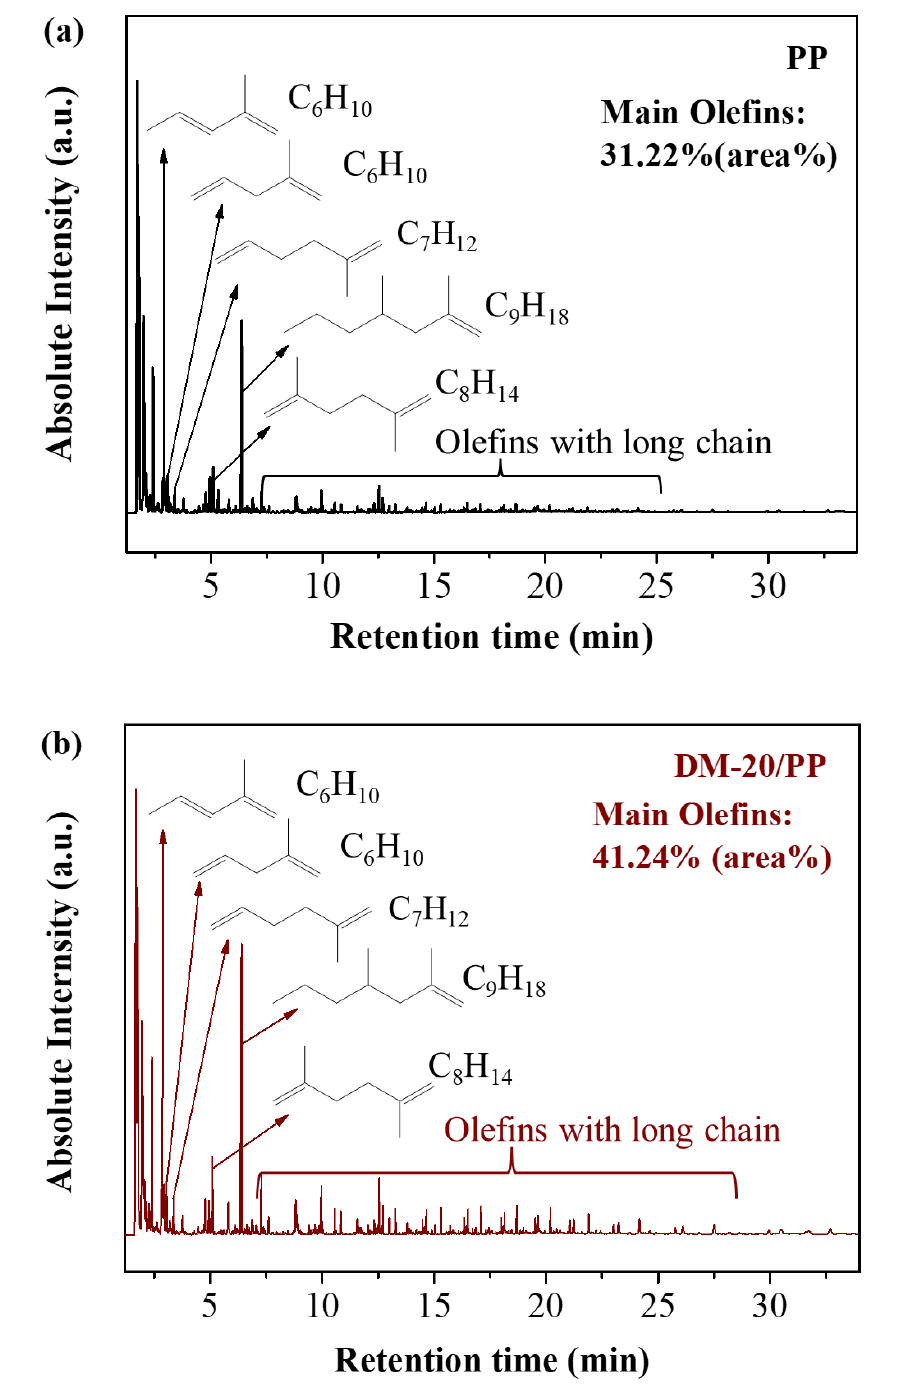
Figure 4. GC–MS chromatograms for the main olefins evolved from the thermal degradation of ( a ) PP and ( b ) DM–20/PP.